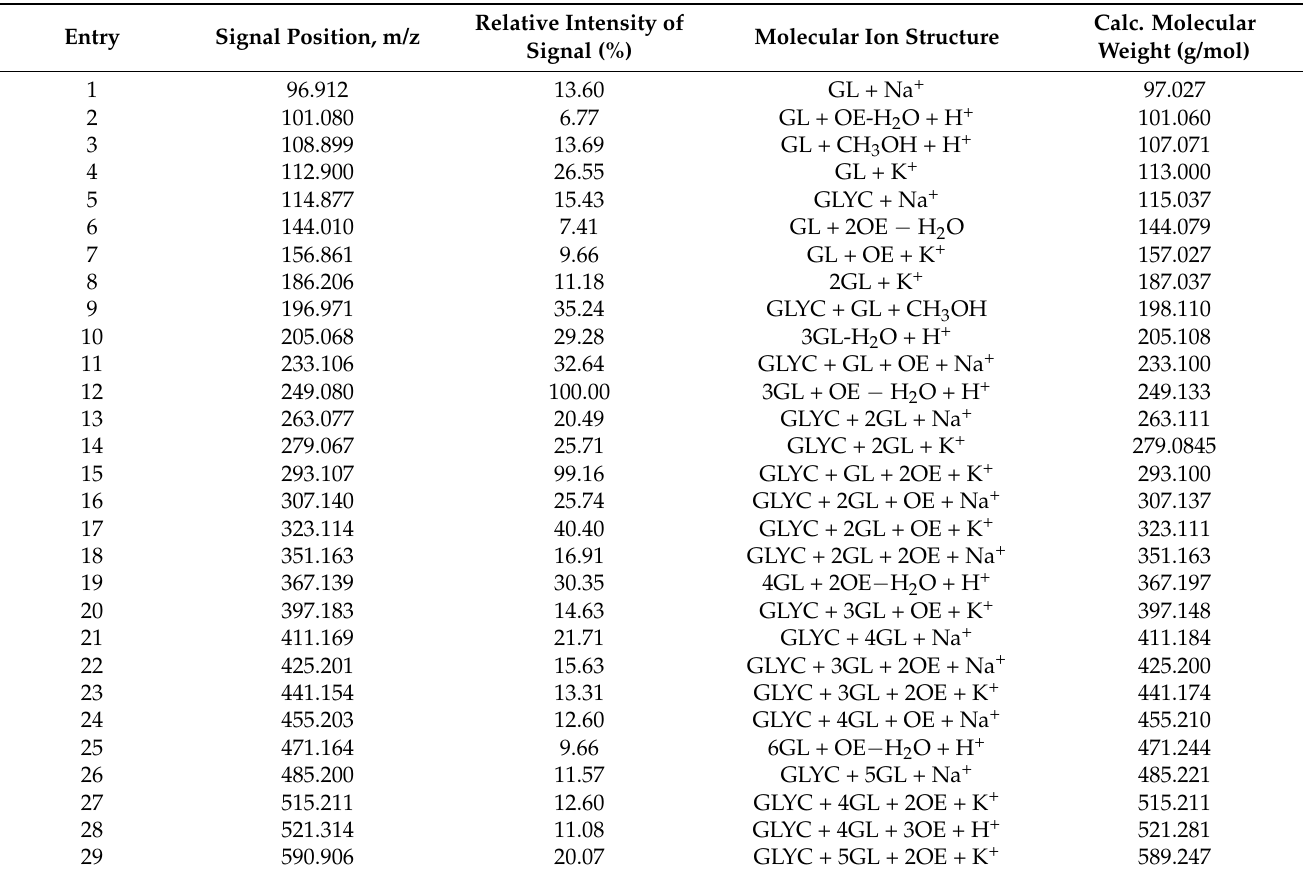
Table 2. Interpretation of MALDI-TOF spectrum of polyol (CS + H 2 O +GL) +